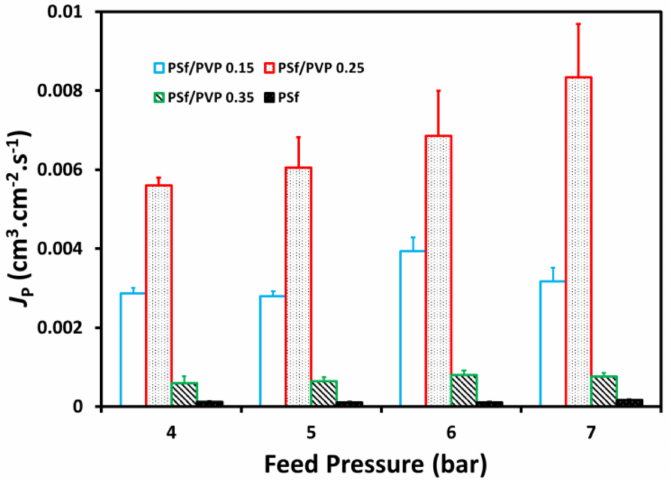
Figure 6. Effect of feed pressure on pure water flux, J p .